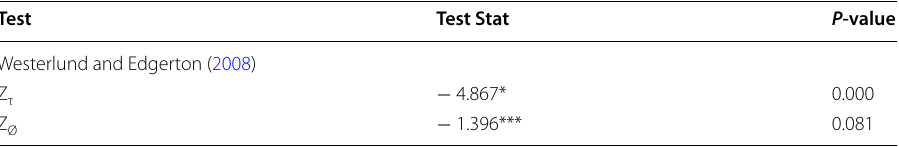
* and ***Indicate the rejection of the null hypothesis at 1% and 10% significance levels,